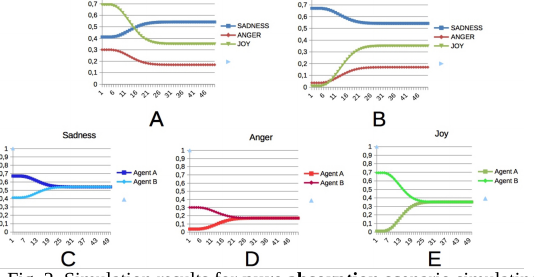
Fig. 2. Simulation results for pure absorption scenario simulating three emotions SADNESS , ANGER and JOY : A) emotional dynamic of agent A Fig. 1. Simulation scenario. during the simulation, B) emotional dynamic of agent B during the simulation, C) emotional dynamic of emotion SADNESS of agents A and B , D) emotional dynamic of emotion ANGER of agents A and B , and E) emotional dynamic of emotion JOY of agents A and B during the simulation. The horizontal axis denotes time elapsing in number of iterations and the vertical axis denotes emotional level. Notice how emotions tend to converge to an average point in the pure absorption